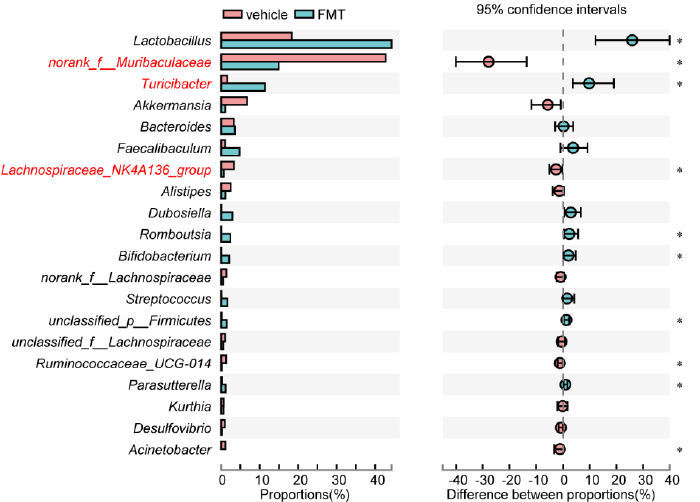
Figure 7. Relative abundances of the top 20 genera. The red font indicates there was also a significant difference in the Figure 4 association analysis of the previous experiment. * p < 0.05.